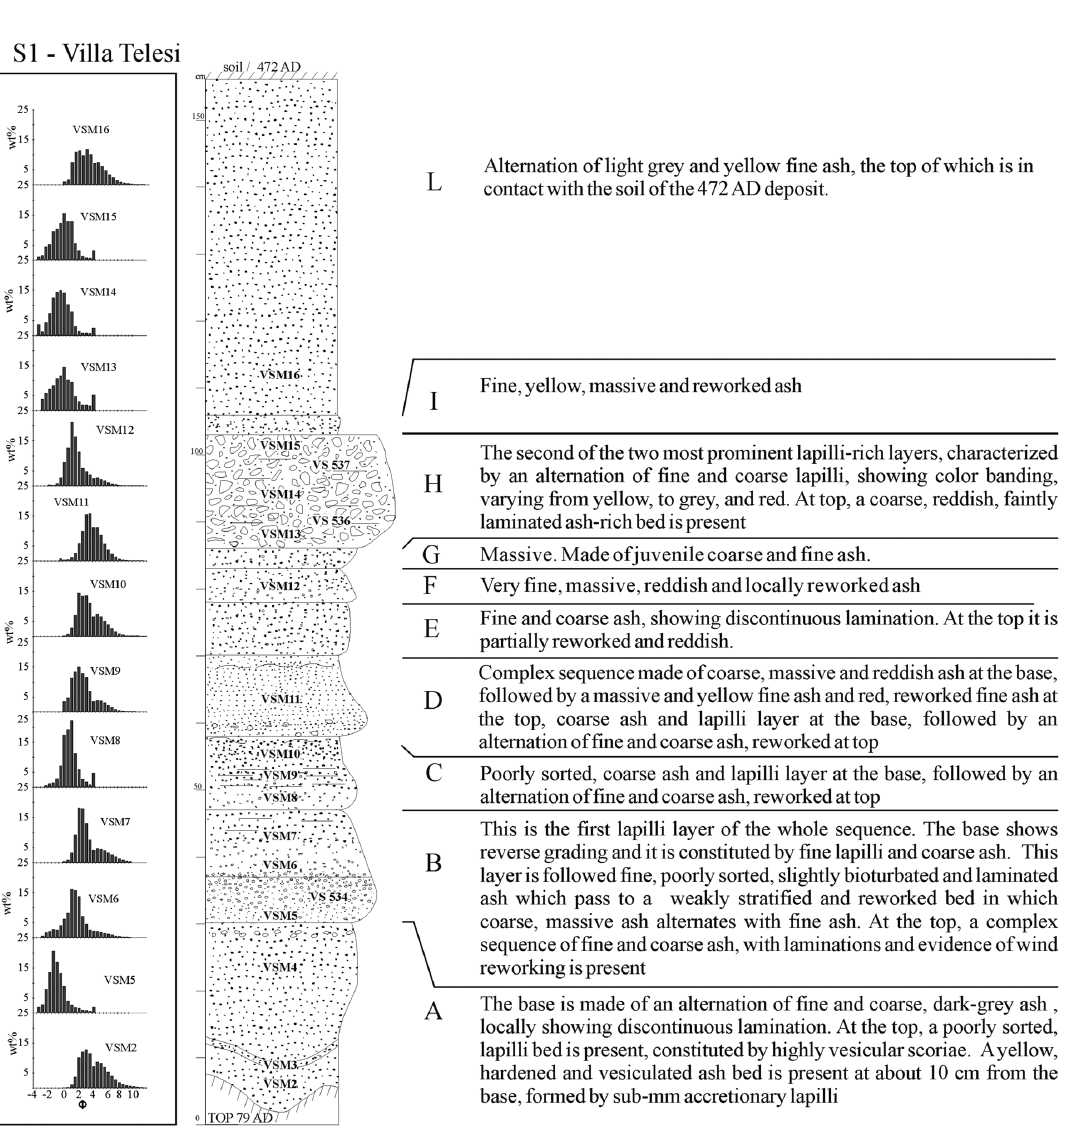
Figure 1. Stratigraphic section of SMM deposit at S1- Villa Telesi outcrop. The different units are indicated, from the base to the top, with the labels A-L. Pictures correspond to the main units and show the position of collected samples. Grain size analyses for the different sam- ples were performed by mechanical agitation at whole U intervals, from −4 to 3 U , and for intervals from 3 to 12 U using a laser particle size analyzer at the Geography Department of Coventry University (UK).